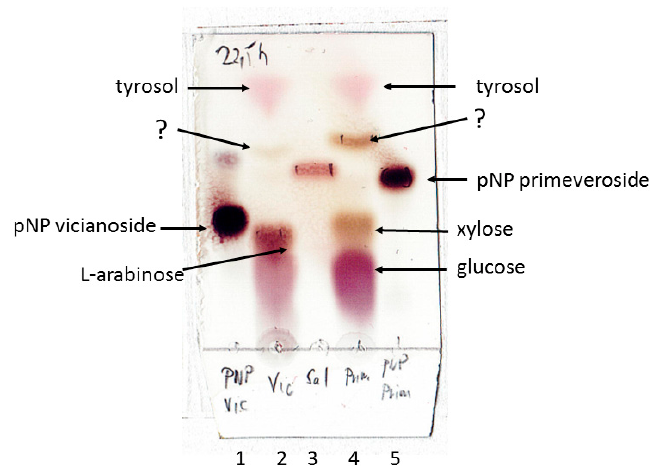
Figure 3. Products of transglycosylations of tyrosol from pNP vicianoside and pNP primeveroside catalyzed by Aromase H2. Line 1: standard of pNP vicianoside. Line 2: reaction of pNP vicianoside with tyrosol. Line 3: standard of salidroside. Line 4: reaction of pNP primeveroside with tyrosol. Line 5: standard of pNP primeveroside.